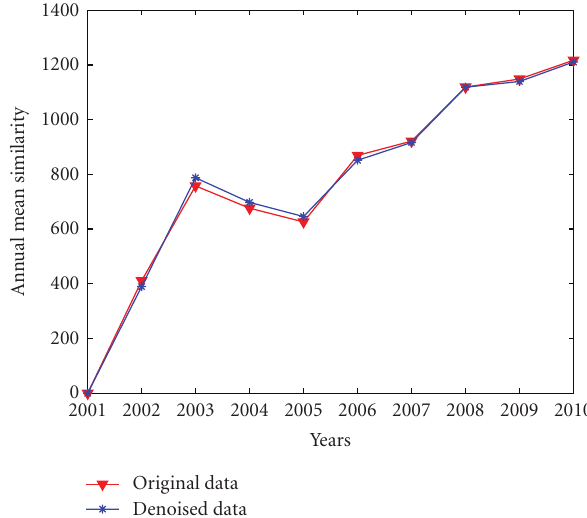
Figure 7: Plots of annual mean similarity versus